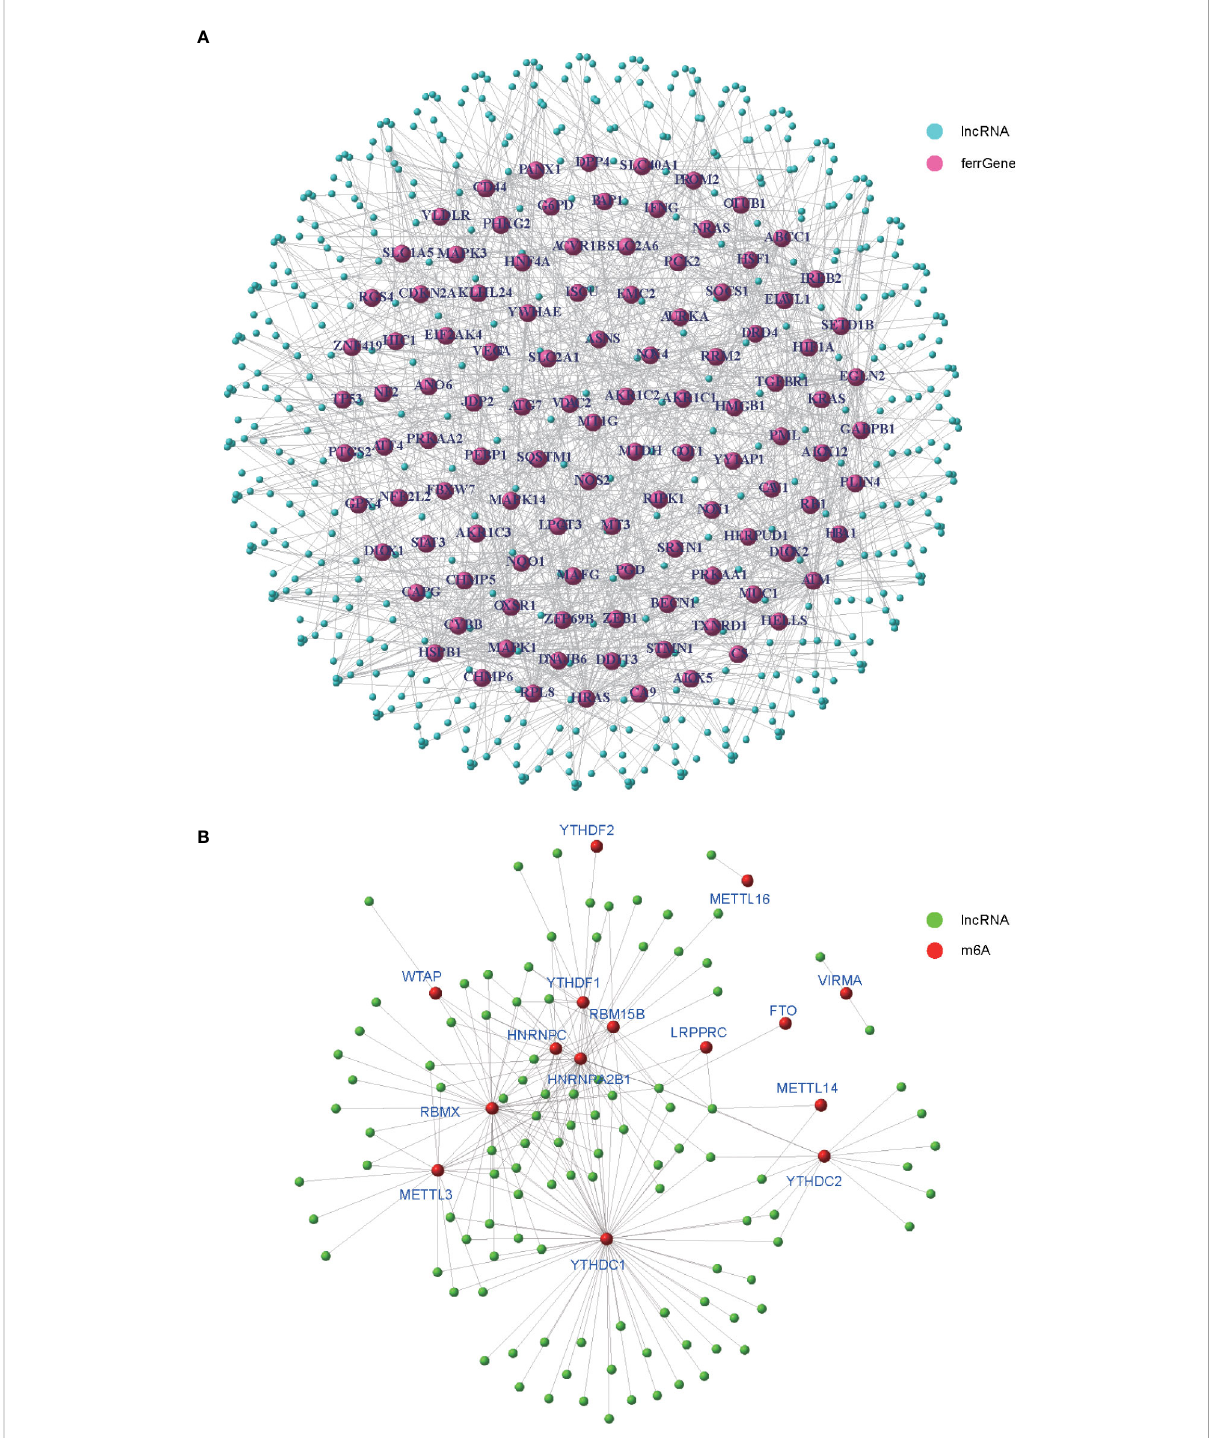
FIGURE 1 Generation of mfrlncRNA. (A) The coexpression network of 201 ferroptosis-related genes (ferrGenes) and 14,080 lncRNAs, named as ferroptosis-related lncRNA (frlncRNA, R = 0.5, p = 0.001). (B) The coexpression network of 23 m6A regulators and 502 frlncRNAs, named as m6A- and ferroptosis-related lncRNA (mfrlncRNA, R = 0.5, p =